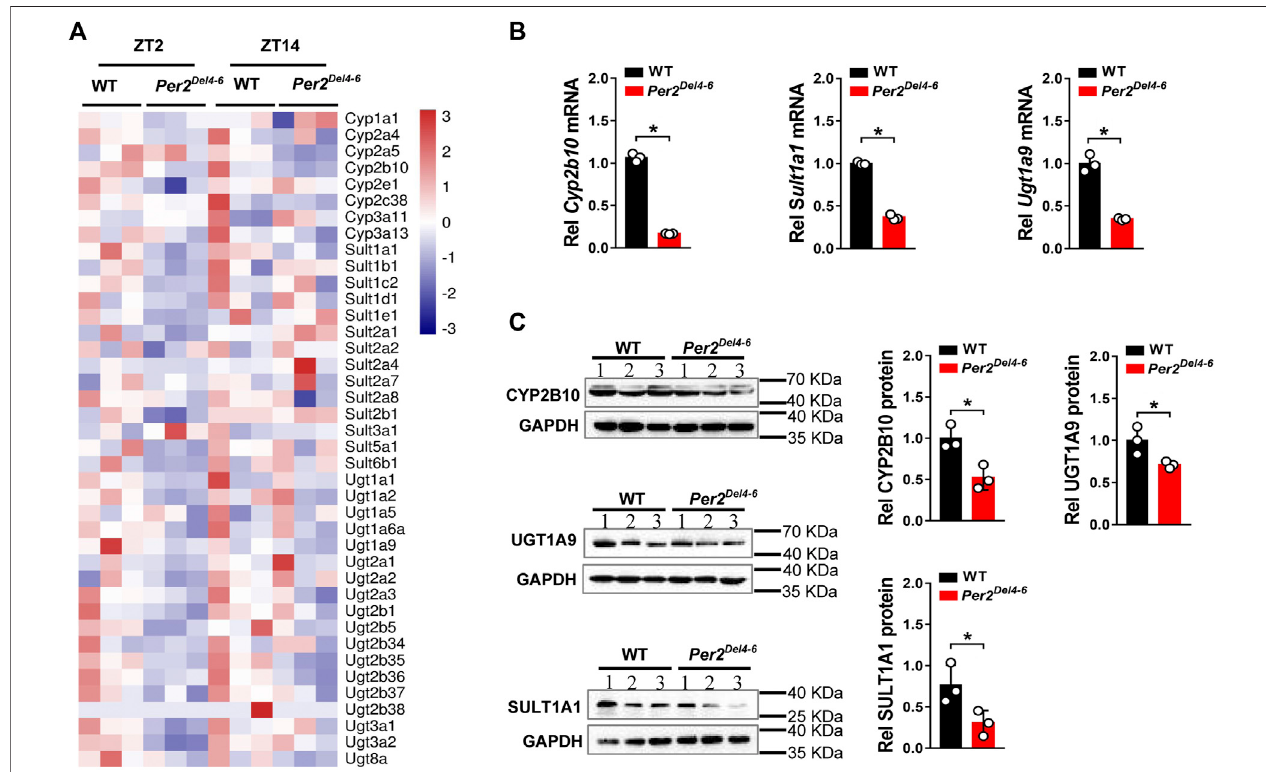
FIGURE2| Expressionofselecteddrug-metabolizing enzymes inPer2 Del4-6 mice. (A) Heatmapshowingrelative mRNAexpression ofdrug-metabolizingenzymes atZT2andZT14in Per2 Del4-6 versusinWT(wild-type)mice. (B) mRNAexpressionlevelsofthreedrug-metabolizinggenes( Cyp2b10,Ugt1a9 and Sult1a1 )intheliversof Per2 Del4-6 and WT mice. (C) Protein expression levels of CYP2B10, UGT1A9 and SULT1A1 in the livers of Per2 Del4-6 and WT mice. Western blot strips (a target protein and a loading control) were cut from one gel. Data are mean ± SD ( n (cid:1) 3). * p < 0.05 (t test). Rel, Relative. ZT, zeitgeber time.